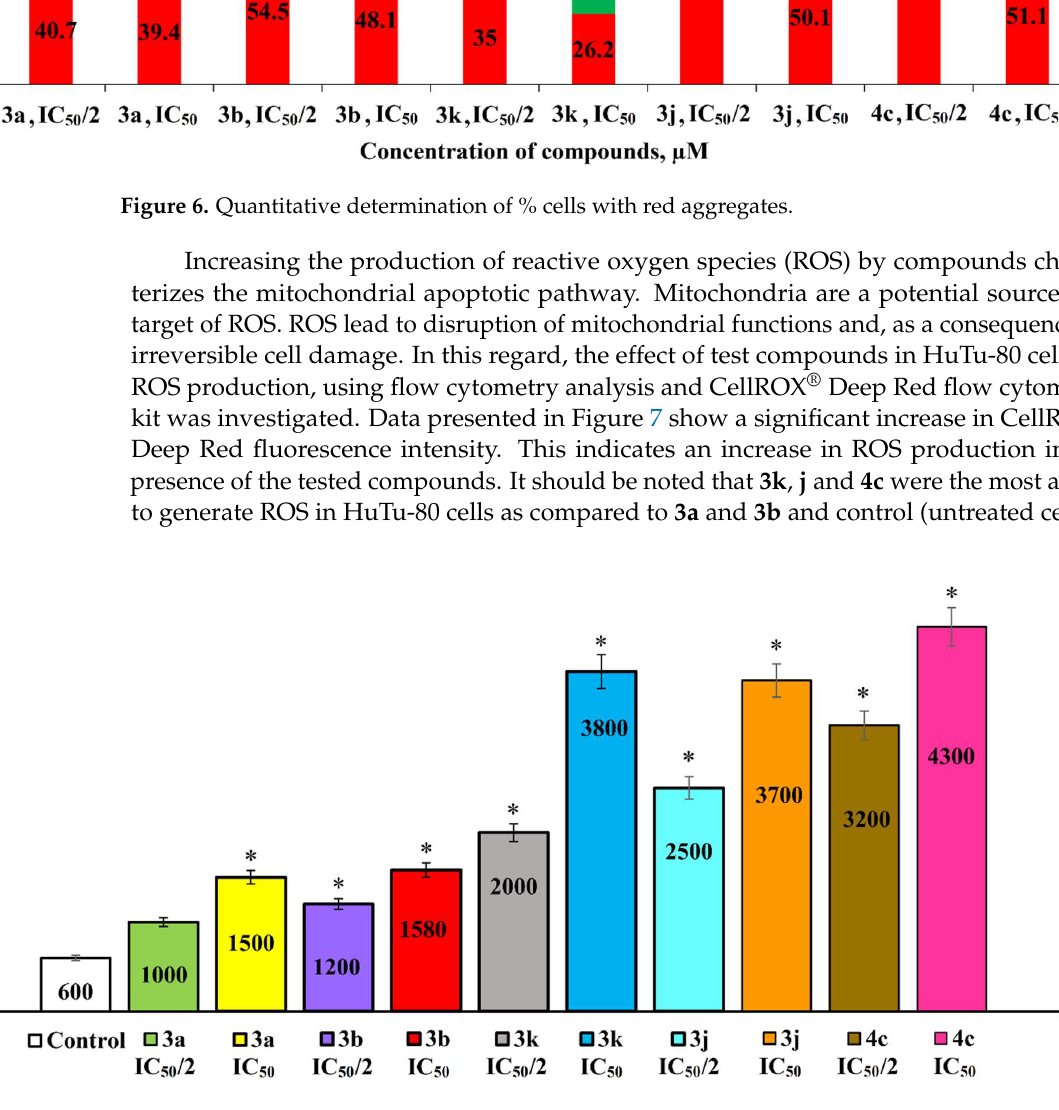
Figure 7. Induction of ROS production by 3a , b , k , j and 4c at the concentration of IC 50 /2 and IC 50 in µ M for 48 h; ( ∗ ) p < 0.05 ompared to control.